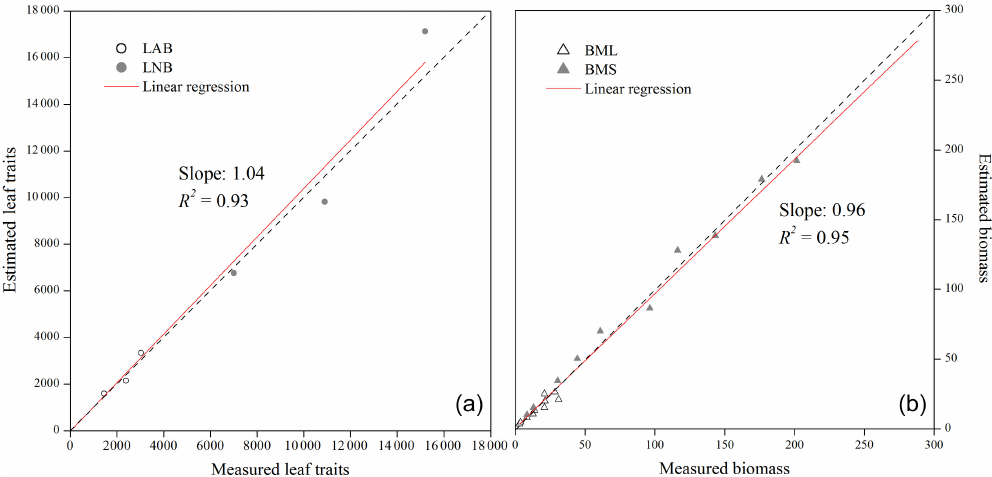
Figure 4. Verification of the allometric models for estimating the biomass and leaf traits of C. korshinskii . BML and BMS refer to the biomass of the leaves and stems, respectively, and LAB and LNB refer to the leaf area and the number of branches,